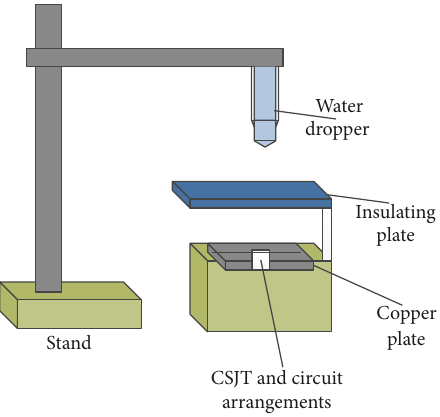
Figure 11: Schematic of the experimental set-up for estimation of thermal